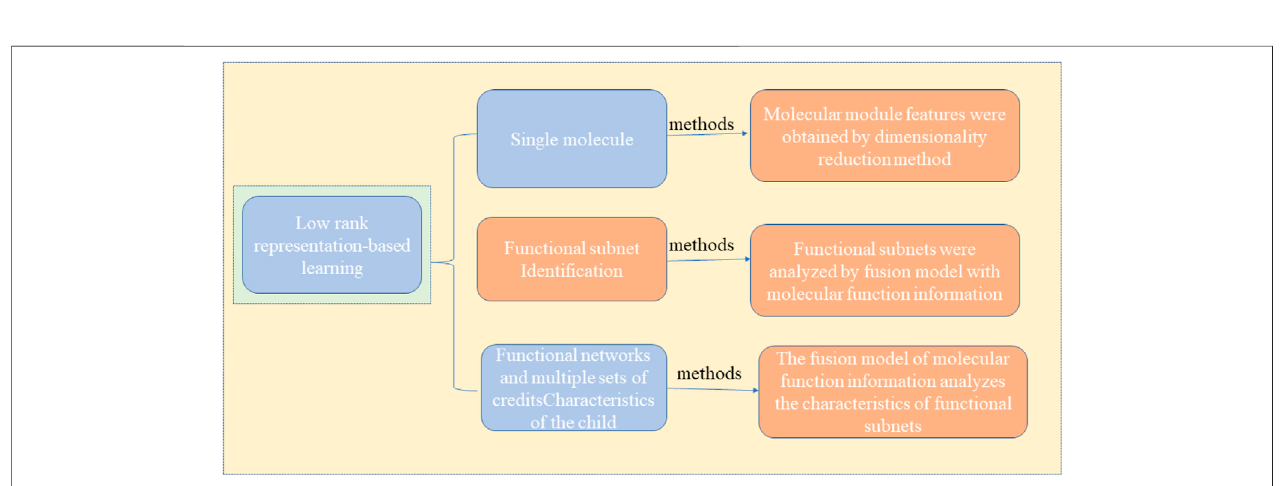
FIGURE 2 | Method for mining cancer molecular features using a low-rank representation